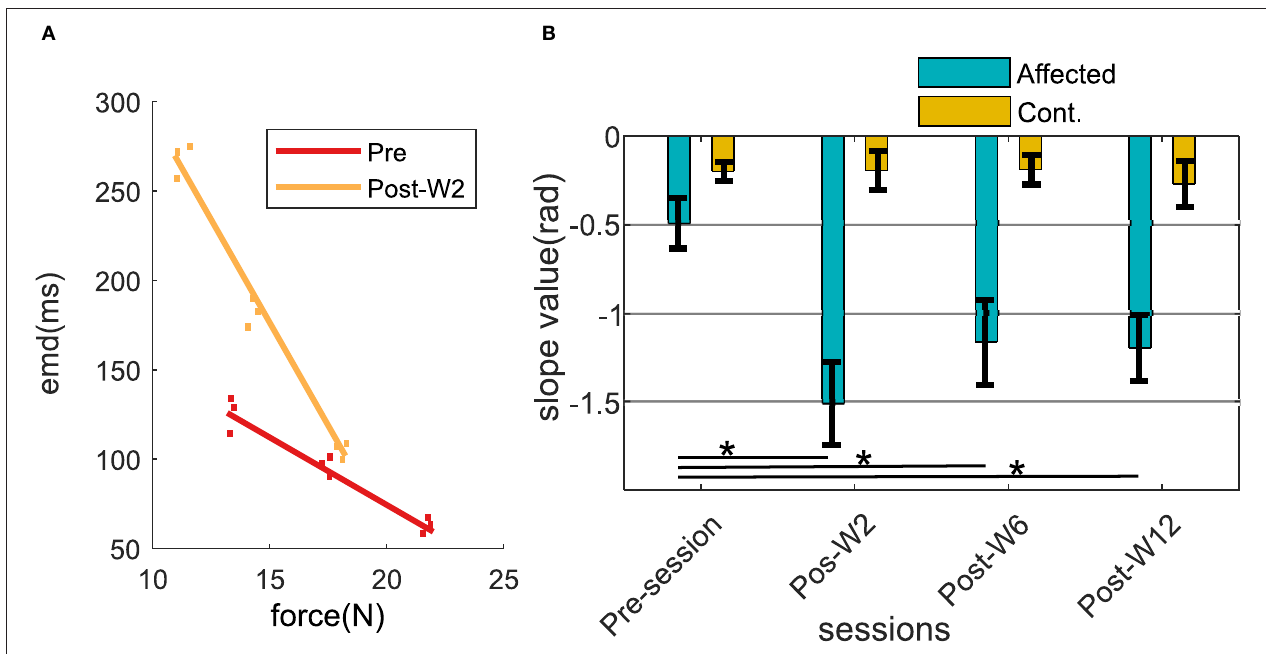
FIGURE 6 | (A) Force-EMD regression slope of subject B2 during Pre- and Post-W2 session in the affected side. (B) Slope value across different experimental sessions for all the subjects represented in radians. The column height represents the mean, while the error bar represents the standard deviation of the ZC values at the session for the subjects. Statistically significant difference of the EMD values in the affected side across sessions ( p < 0.05) is indicated by